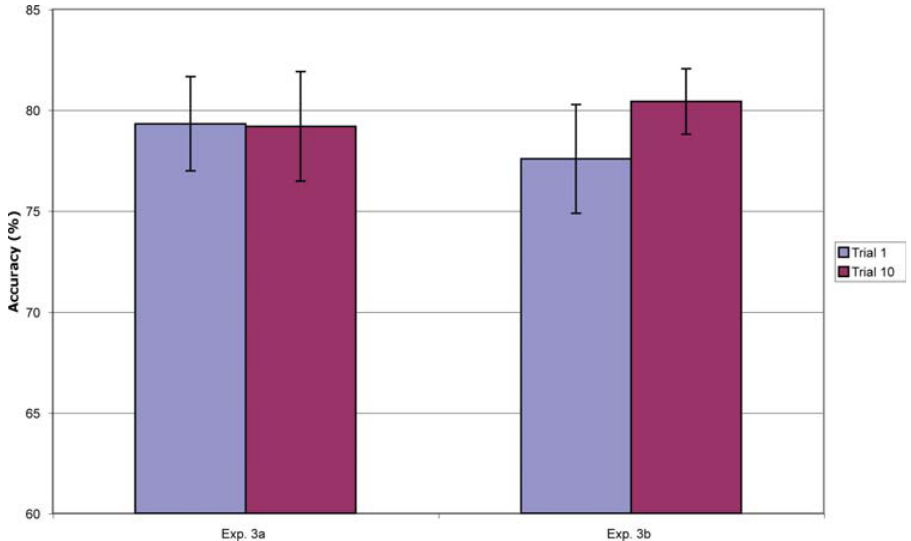
Figure 6. Mean accuracy (with standard errors) for Experiments 3a and 3b, trials 1 and 10 of each mini-block.